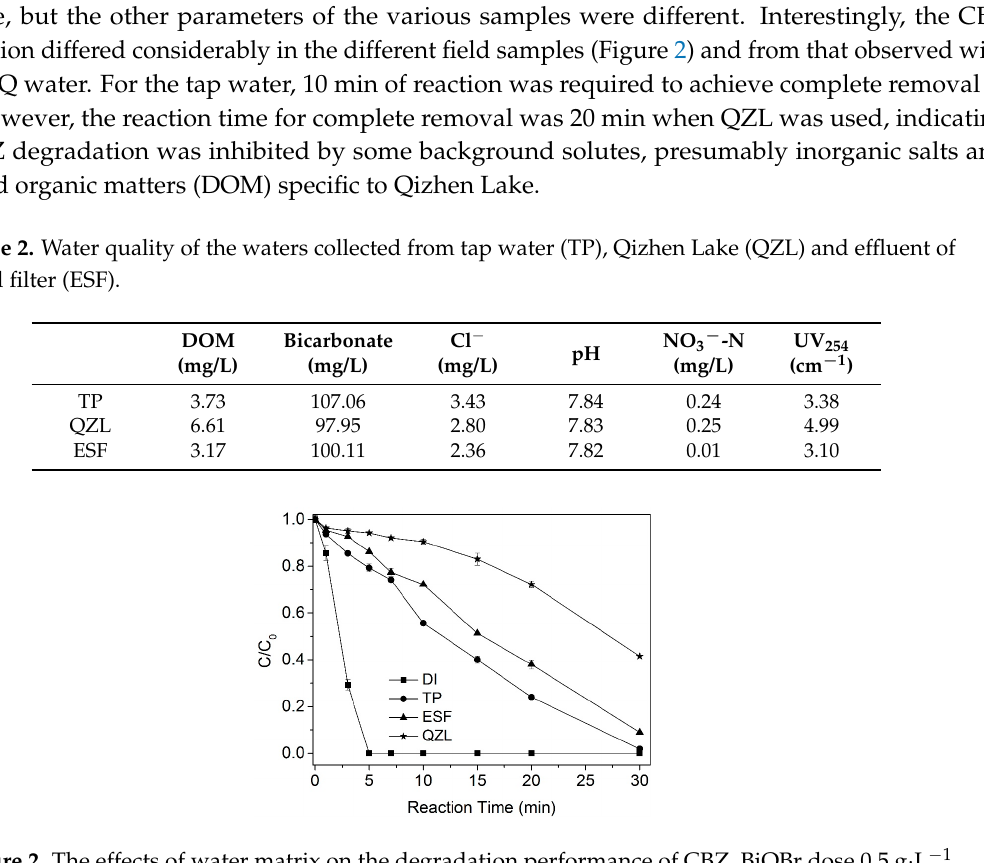
Figure 2. The effects of water matrix on the degradation performance of CBZ. BiOBr dose 0.5 g · L − 1 , [CBZ] 0 = 5 µ M, [PMS] 0 = 4.0 mM, T = 24 ◦